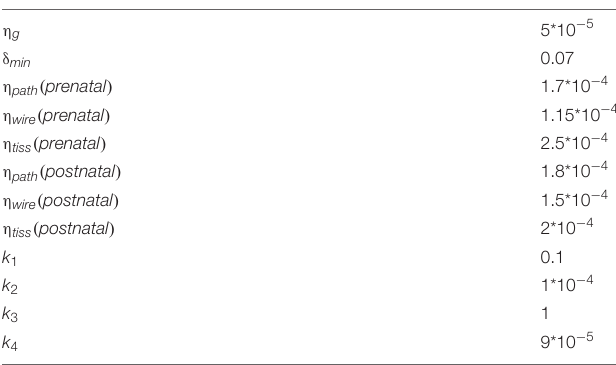
Frontiers in Neuroscience |